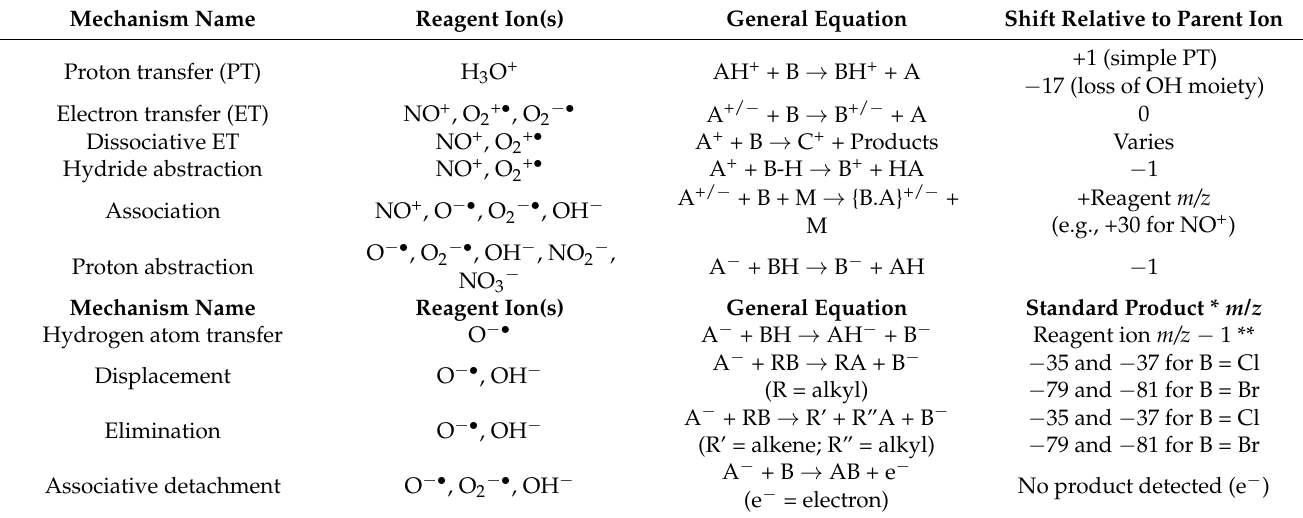
* The reactions in the lower section of the table yield a standard product ion. For displacement and elimination mechanisms, Cl − and Br − product ions have been most commonly encountered to date, so they are used for